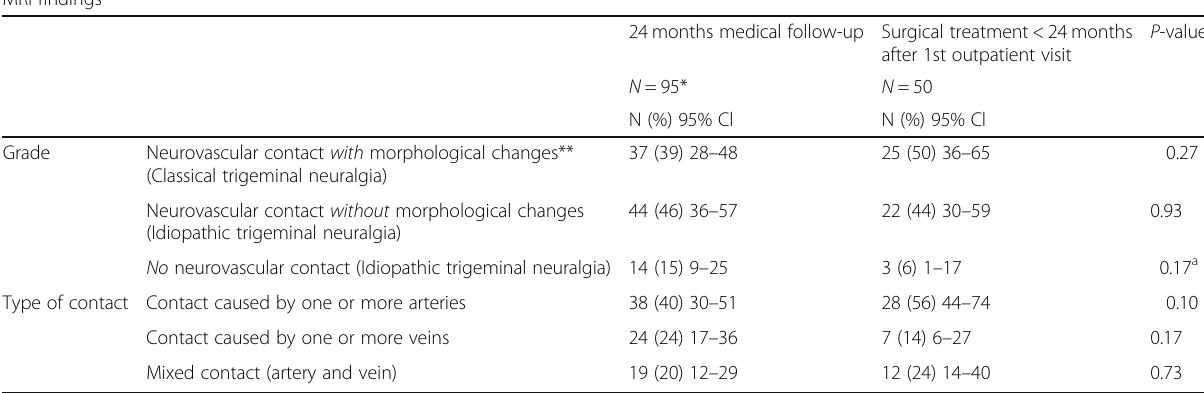
Table 5 Baseline neuroimaging findings MRI